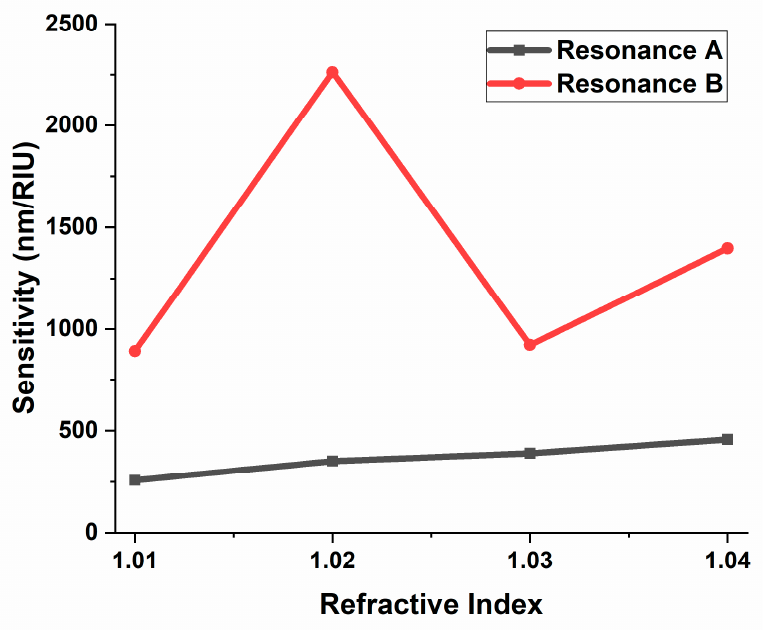
Figure 6. Sensitivity of resonance modes A and B as the refractive index changes.